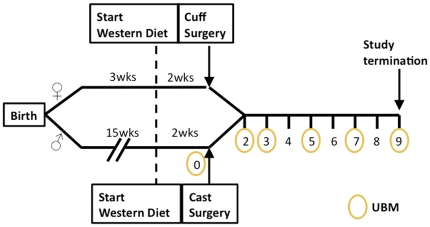
Study time-line.